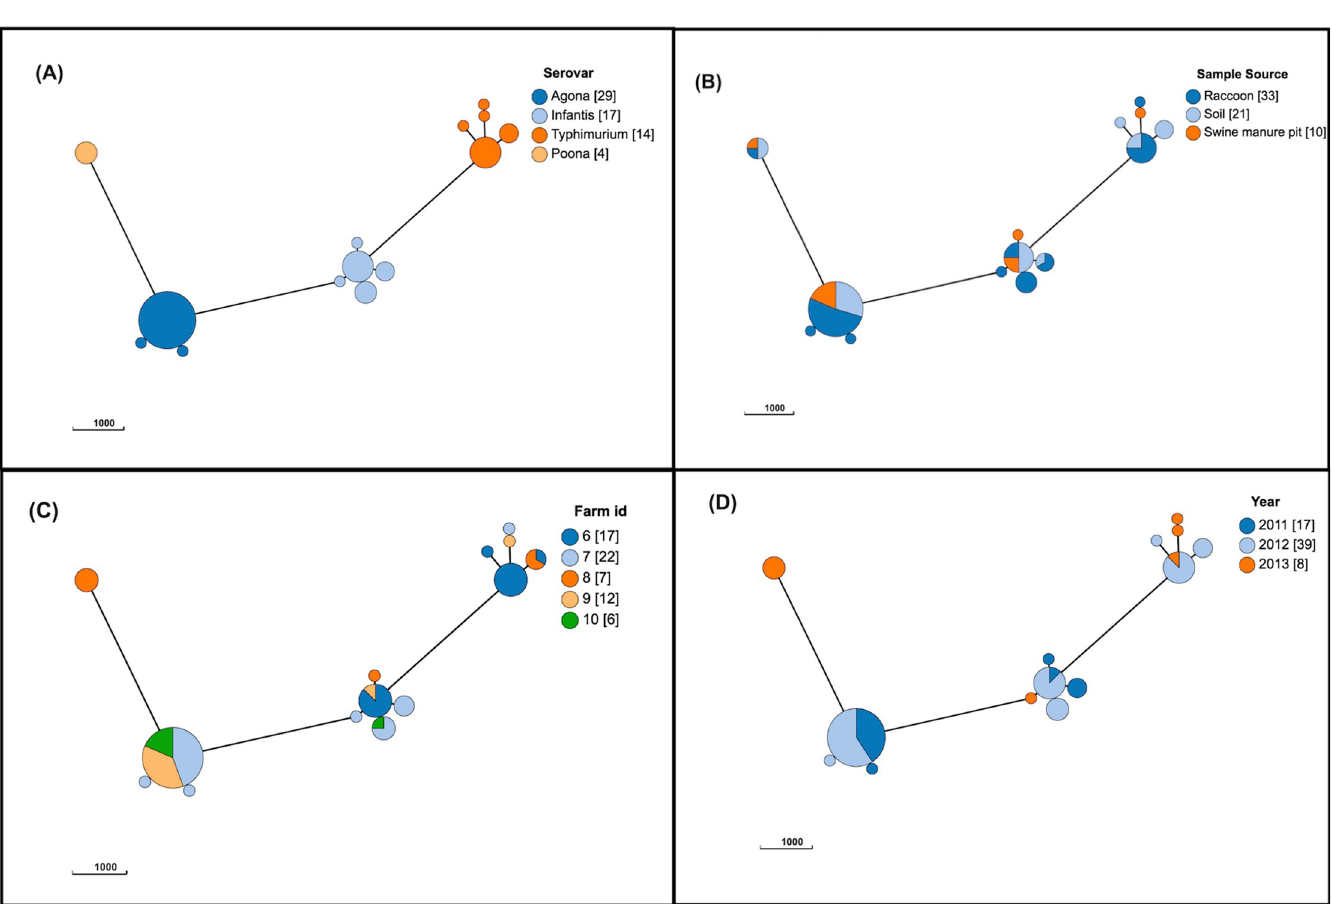
Fig 2. Population structure of 64 isolates of Salmonella enterica isolates from raccoons, swine manure pits, and soil on swine farms in southern Ontario, Canada based on 3002-loci cgMLST scheme from Enterobase, for serovars S . Agona, S . Infantis, S . Typhimurium, and S . Poona (only serovars identified both in raccoon and swine manure pit samples). Minimum spanning tree created using k = 5 clustering threshold in GrapeTree . (A) Population structure with serovars determined using SISTR. (B) Distribution by source type. (C) Distribution by farm. (D) Distribution by year of sampling. Frequency counts are in square brackets. Bubble size is proportional to the number of isolates in each cluster, and each cluster contains isolates differing at a maximum of 5 cgMLST